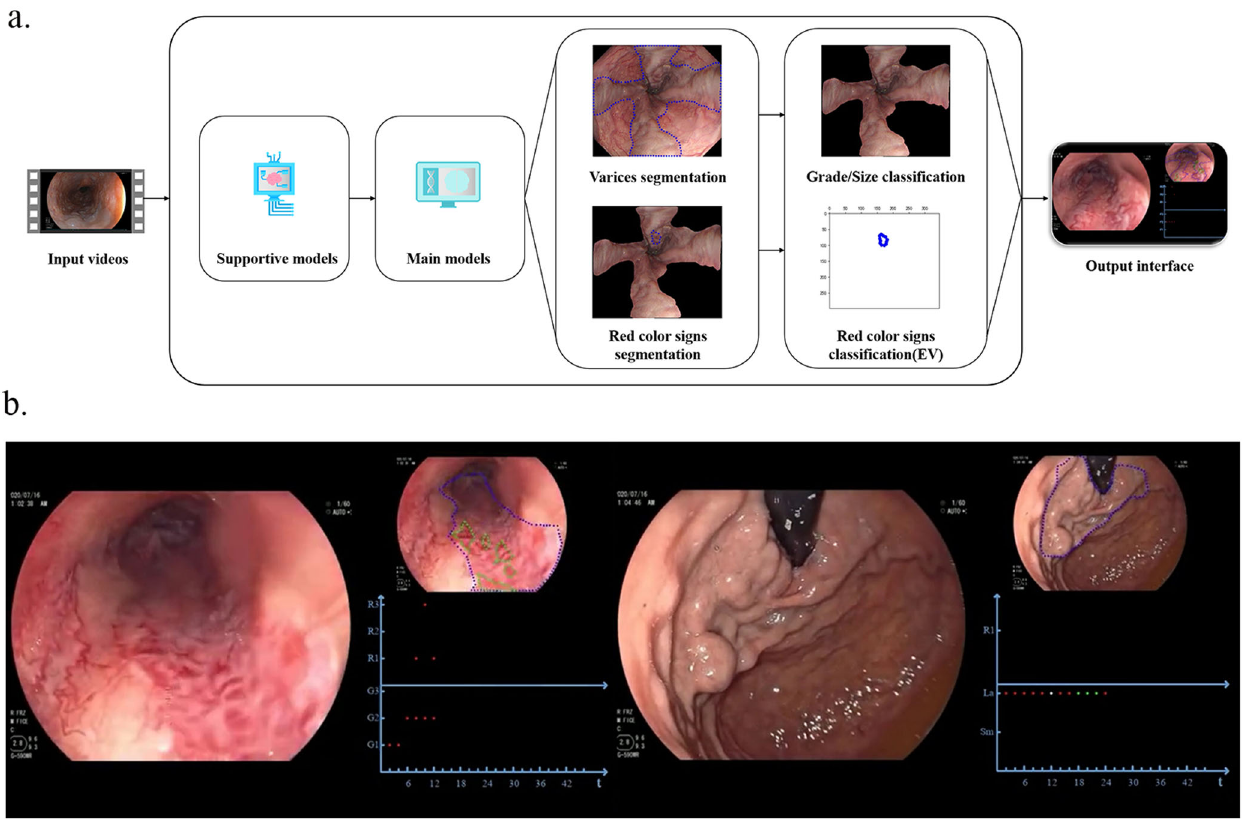
Fig. 3 The framework and interface of the system. a The framework of the system. Videos are input into the system and are analyzed seven frames per second. Firstly, supportive models fi lter unquali fi ed images, and quali fi ed images are processed by main models. Model 1, 2, 5 delineate GEV and RC, then model 3, 4, 6 classify grade and RC. All above features are summarized according to time and regions, and accumulated results are shown on the interface. b The interface of the system. The predicted results were shown on the upper right of the screen. The summarized results change with time, and the region is listed on the interface ’ s lower right. G1: grade 1, G2: grade 2, G3: grade 3, R1: RC1, R2:RC2, R3: RC3, La: large, Sm: small, Red spots: greater curvature, green spots: posterior wall, white spots: anterior wall, blue spots, lesser curvature. GEV gastroesophageal varices, RC red color